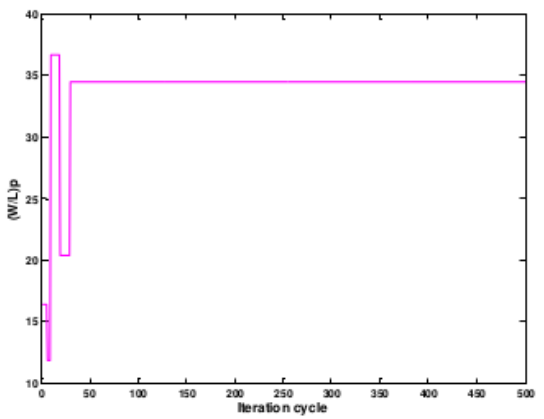
Figure 9: Plot of ( W / L ) p versus iteration cycle for the eighth design set of CRPSO for Case study-3.